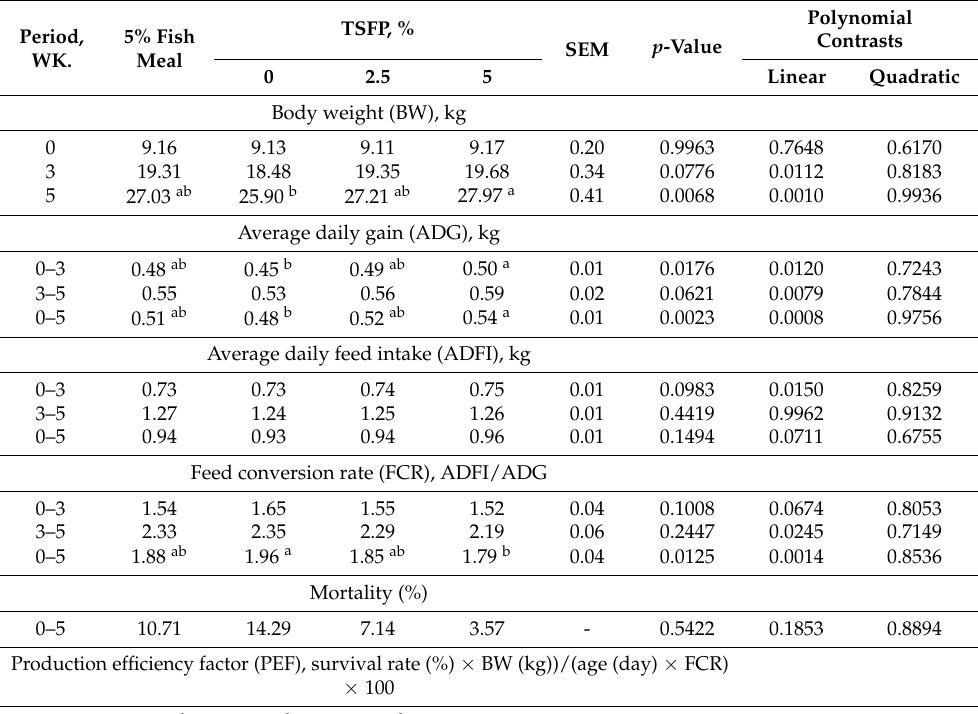
Table 6. Effects of different supplementation levels of TSFP 1 on the growth performance of nursery pigs in trial